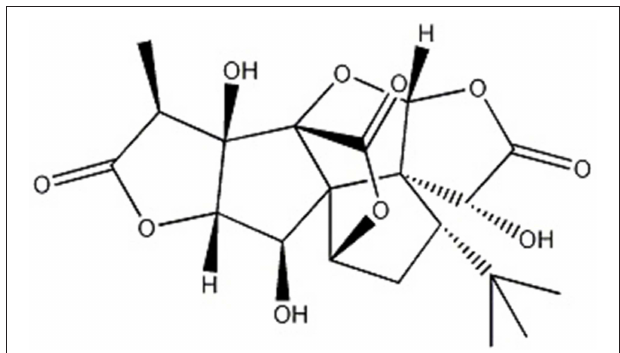
FIGURE 1 | Chemical structures of GB (C 20 H 24 O 10